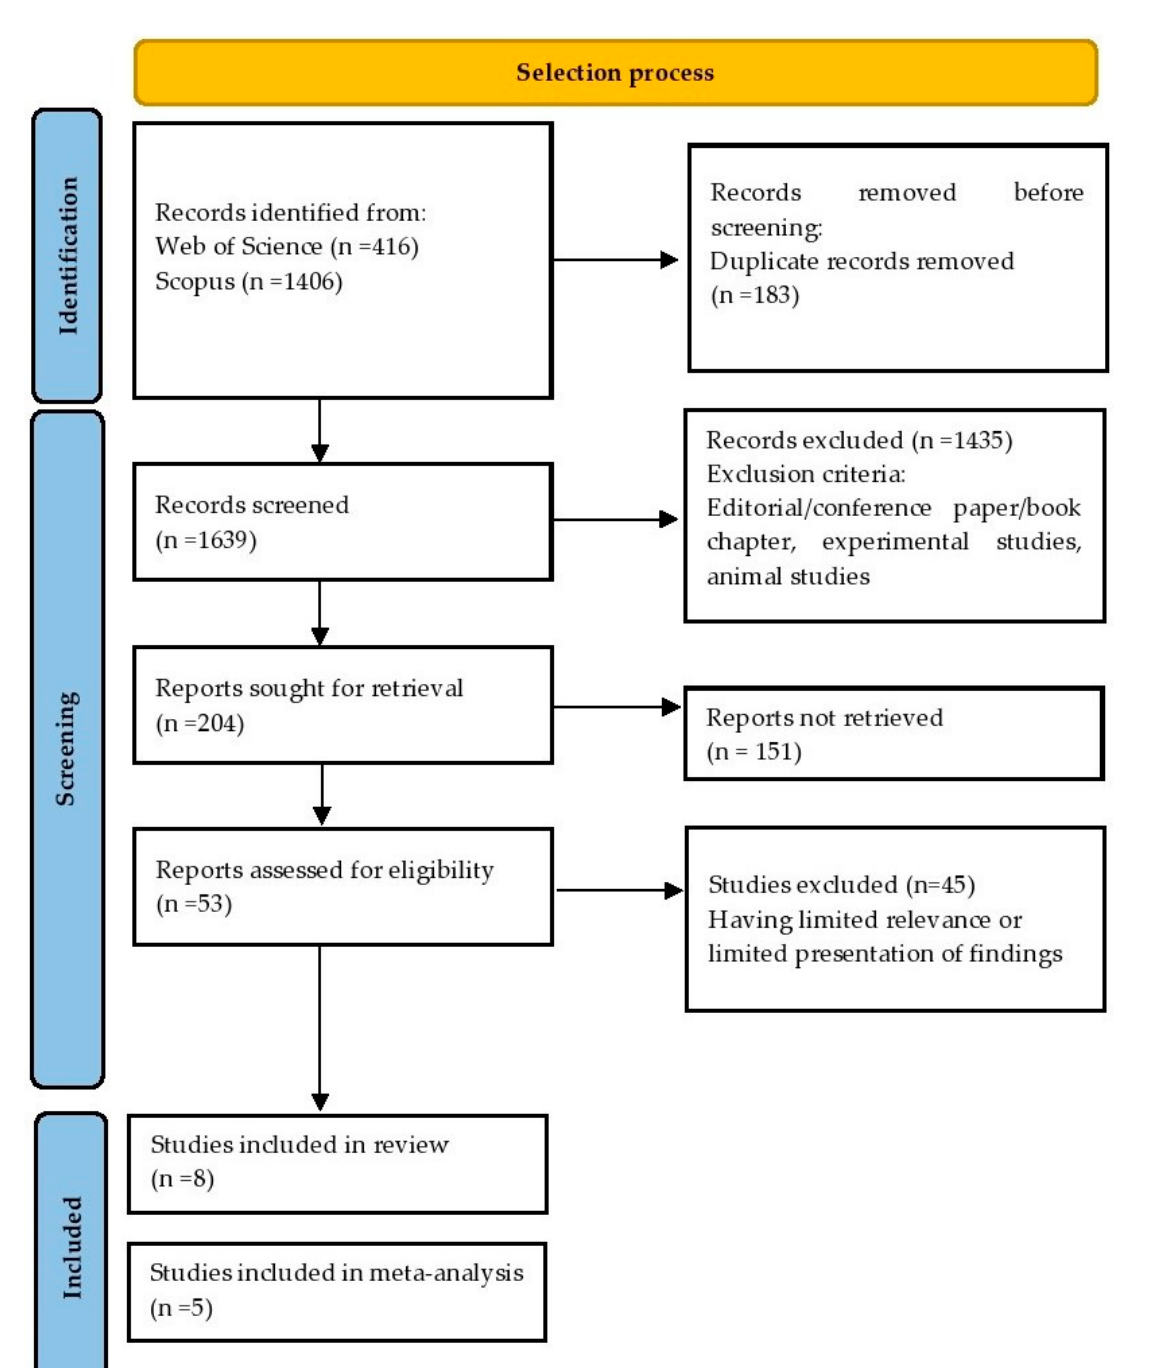
Figure 1. Flowchart presenting the selection